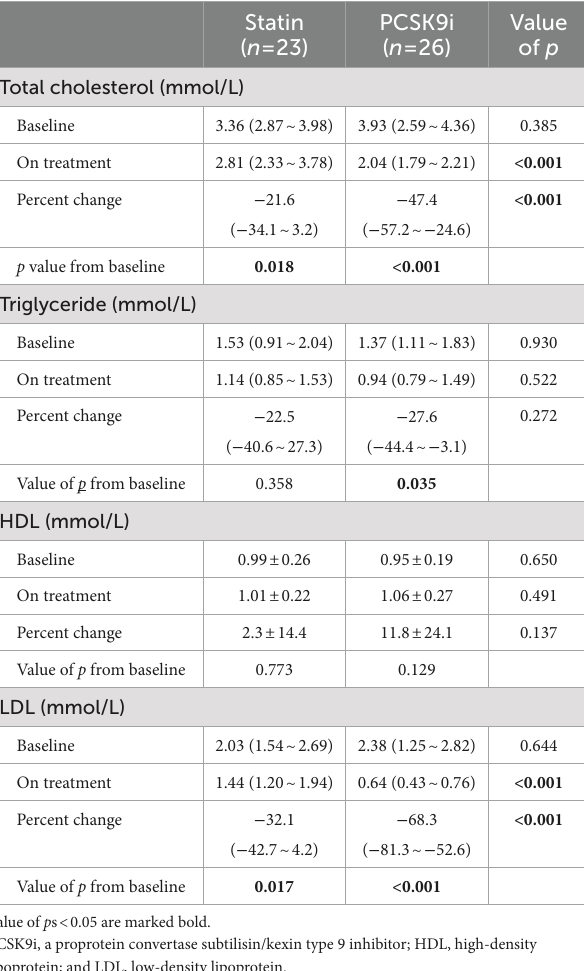
lipoprotein; and LDL, low-density